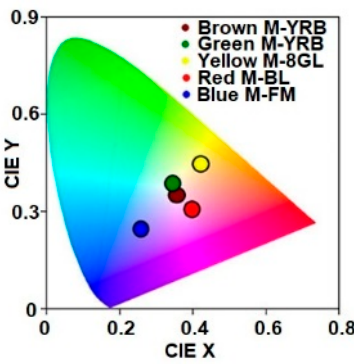
Figure 1. Chromaticity coordinates of colored